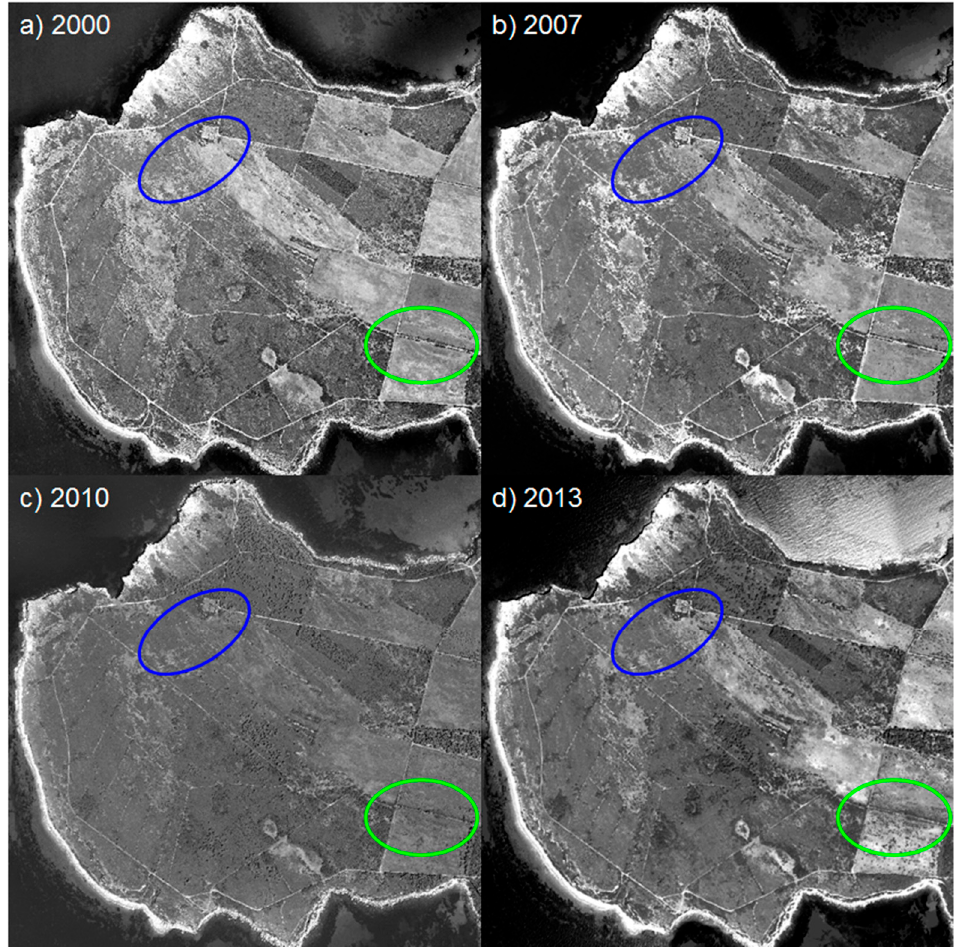
Figure 7. Visual comparison of the digital aerial orthophotos for two areas located in the western (blue) and south-western (green) of Pianosa Island, respectively. Images were taken by Regione Toscana–SITA: Cartoteca for the years ( a ) 2000, ( b ) 2007, ( c ) 2010, and ( d ) 2013.